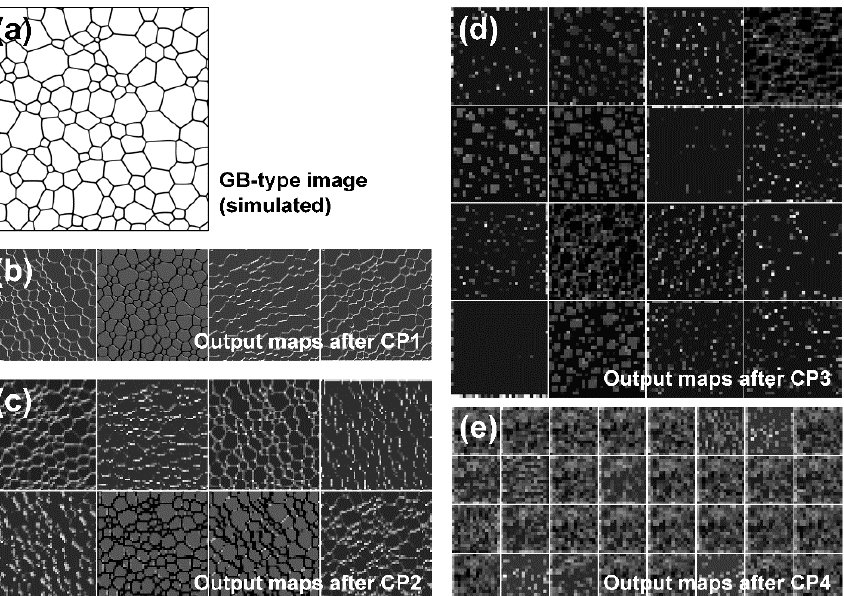
Figure 10. Mid-layer images for a simulated GB-type image. ( a ) Original image (512 × 512 pixels) and mid-layer images after ( b ) CP1 (128 × 128 pixels each), ( c ) CP2 (64 × 64 pixels each), ( d ) CP3 (32 × 32 pixels each), and ( e ) CP4 (16 × 16 pixels each) layers.